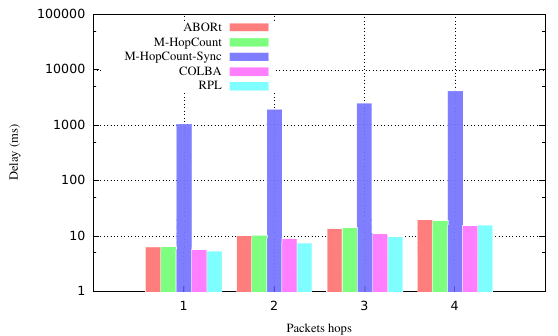
Figure 7. Queue overflow ratio for 10 pkts/s/node.